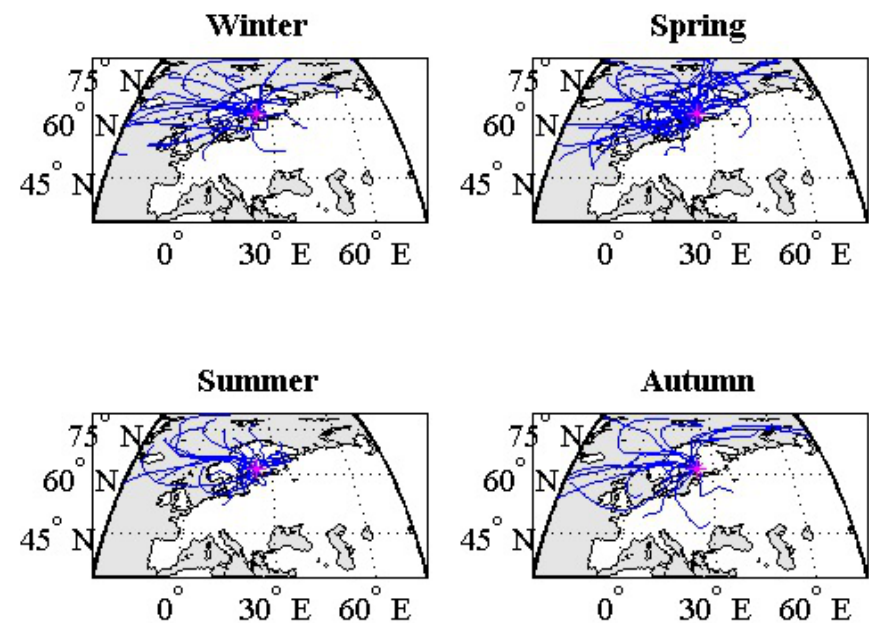
Fig. 12. Seasonal 4-day air mass back trajectories arriving at Hyyti¨al¨a (2005) for the samples where REMO-HAM is moderately (not more than 300ngm − 3 ) underestimating the measurements.